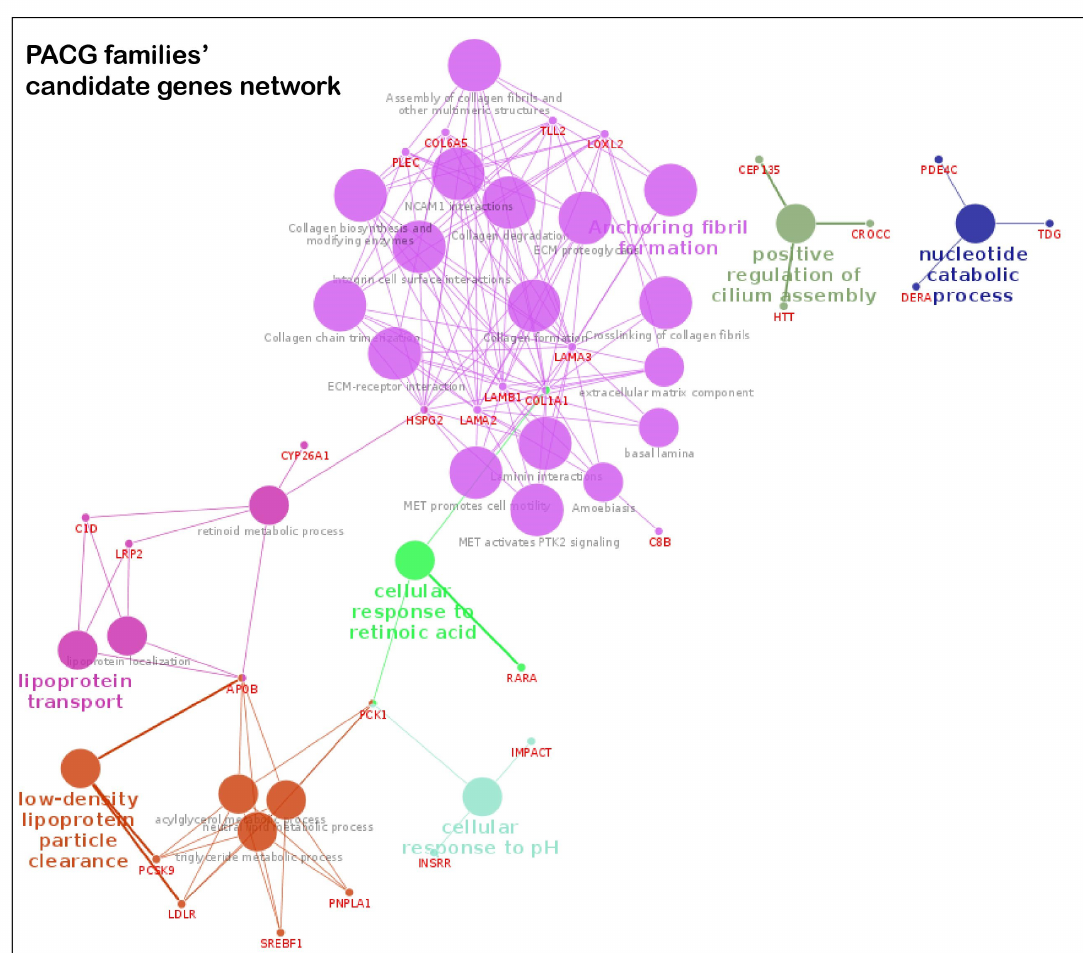
Figure 4. Pathway enrichment from POAG/PACG candidate genes. The interactions of known and candidate genes are represented. The node represents the GO, KEGG, WikiPathways and REACTOME items. The size of the node represents the significance; smaller nodes have higher and larger nodes have lower significance. The highlighted pathway is labeled according to the highest significance. The color of the nodes is visualized on the basis of different functional groups. Panel A is the genetic network map from candidates genes of POAG families and panel B is the same from the PACG